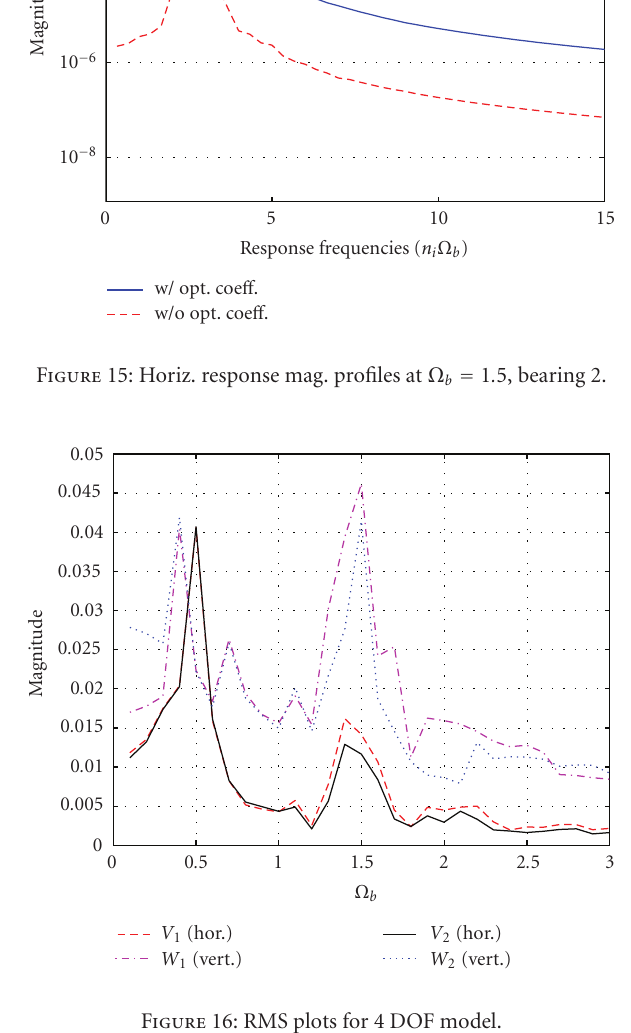
Figure 14: Horiz. response mag. profiles at Ω b = 1 . 4, bearing 1.